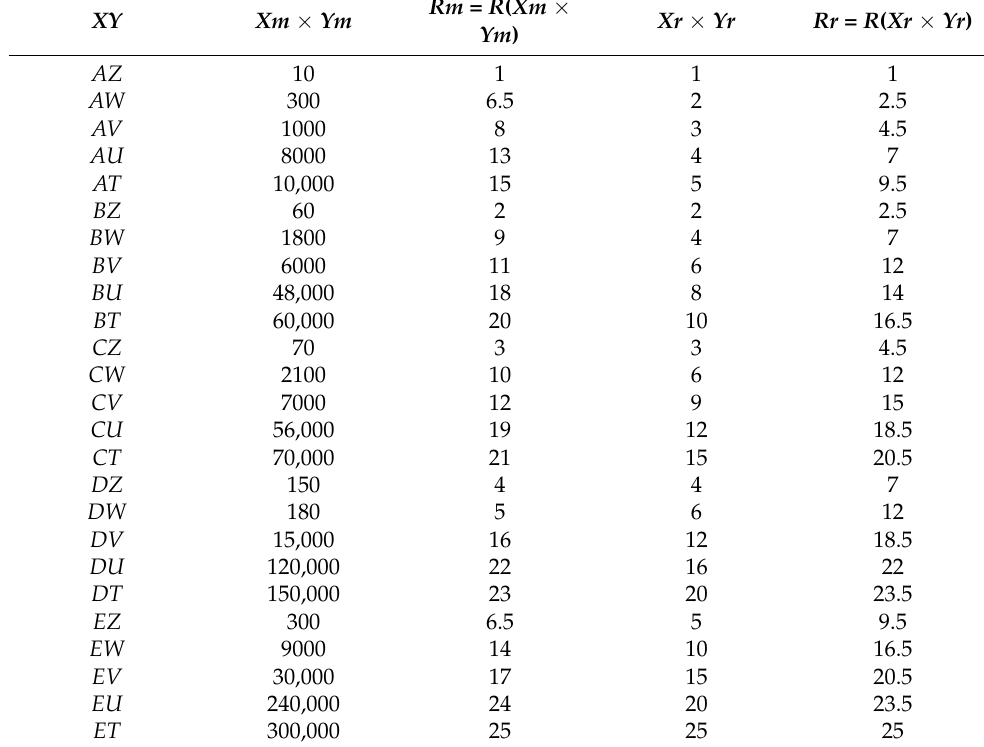
Table A1. Results of multiplication of initial data ( XY —the point name; Xm × Ym —a product of metric quantities; R ( Xm × Ym )—rank of the product in the general array Xm × Ym ; Xr × Yr —a product of rank values of initial data; R ( Xr × Yr )—rank of the product in the general array Xr × Yr